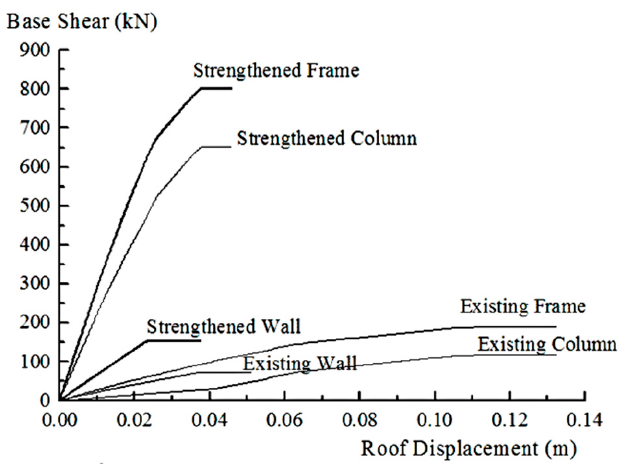
Figure 12. Comparison of the original concrete building structure and reinforced concrete building structure.